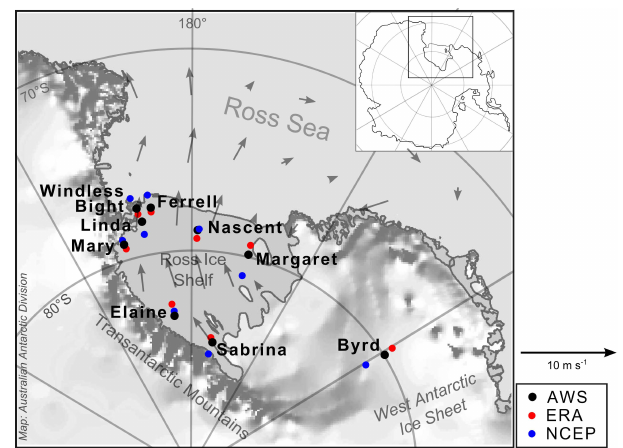
Fig. 1. Locations of the automatic weather stations (AWS) used in this study and corresponding grid point locations for ERA-Interim (red) and NCEP-2 (blue) reanalyses. Wind vectors show the clima- tological surface wind regime (850hPa) over the RIS and Ross Sea (from ERA-Interim monthly data averaged over